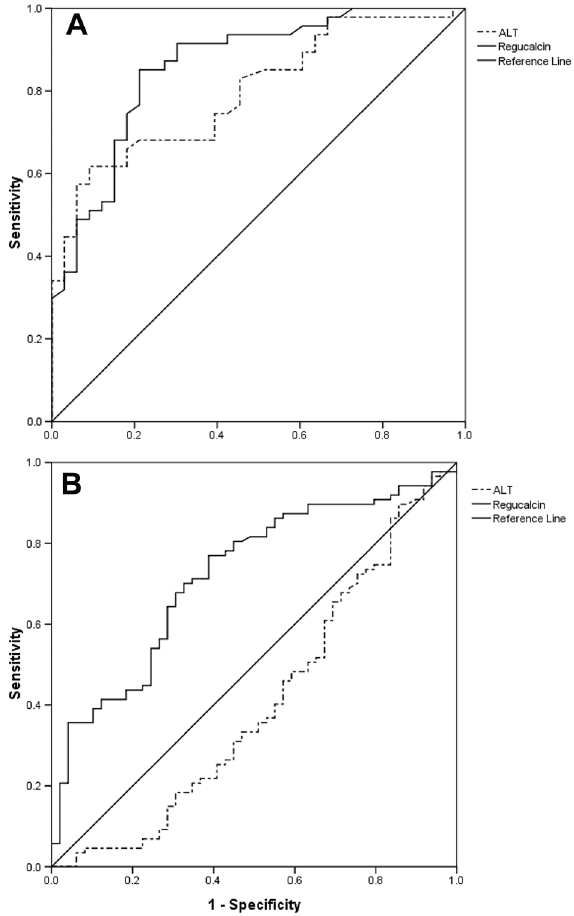
Figure 3. Receiver operating characteristic (ROC) curves for regucalcin (RGN) and alanine aminotransferase (ALT) in chronic hepatitis B (CHB) ( A ) and acute-on-chronic liver failure (ACLF) ( B ) patients. A , The area under the curve (AUC) for RGN was 0.86 with a cut-off of 2.42 ng/mL. The sensitivity and speci fi city were 85.7 and 78.8%, respectively. The AUC for ALT was 0.80 (95%CI: 0.70 – 0.89, P o 0.01) with a cut-off of 28.30 U/L (sensitivity: 0.62 and speci fi city: 0.91), which is lower than the AUC for RGN (P=0.01). B , The AUC for RGN was 0.72 with a cut-off of 4.26 ng/mL. The sensitivity and speci fi city were 77.0 and 61.2%, respectively. In contrast, the AUC of ALT was only 0.41 (95%CI: 0.30 – 0.51, P=0.07) (P o 0.01).